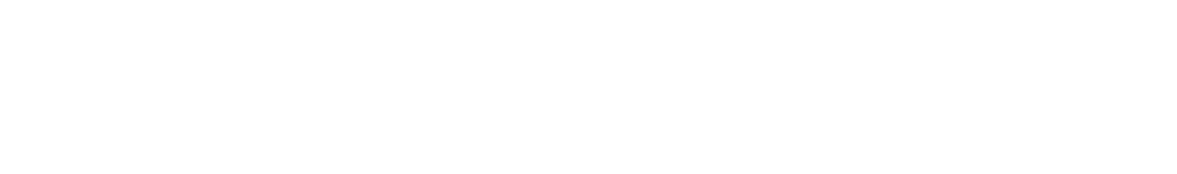
Frontiers in Physics |